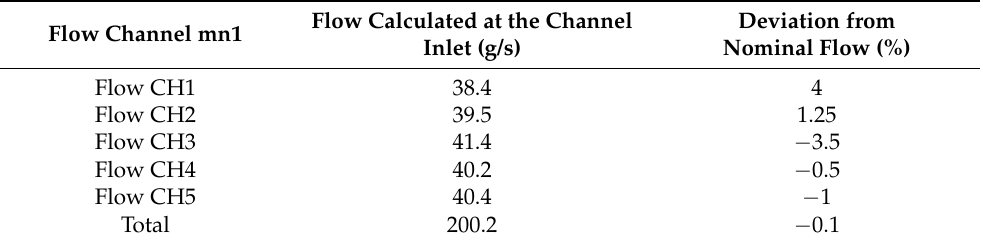
Figure 3. Geometry of the inlet/outlet manifolds: ( a ) ODS mock-up; ( b ) FG mock-up. Table 1. Calculated channel flow rates under steady-state conditions and deviation from the nominal values (positive values represent a deficit in the flow and the negative values correspond to an excess with regard to nominal values).